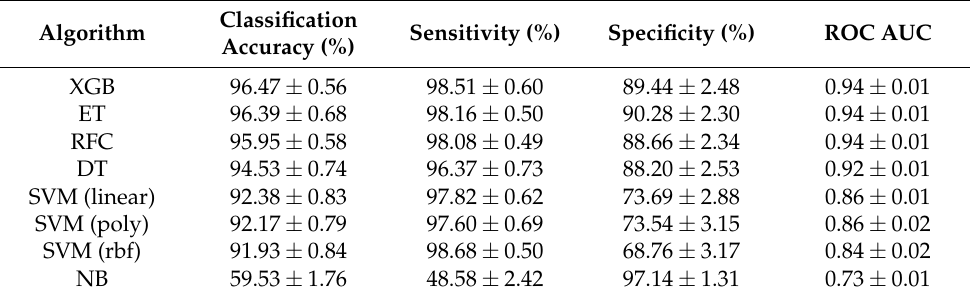
Table 11. Comparison of the best results for each algorithm (dynamic analysis).